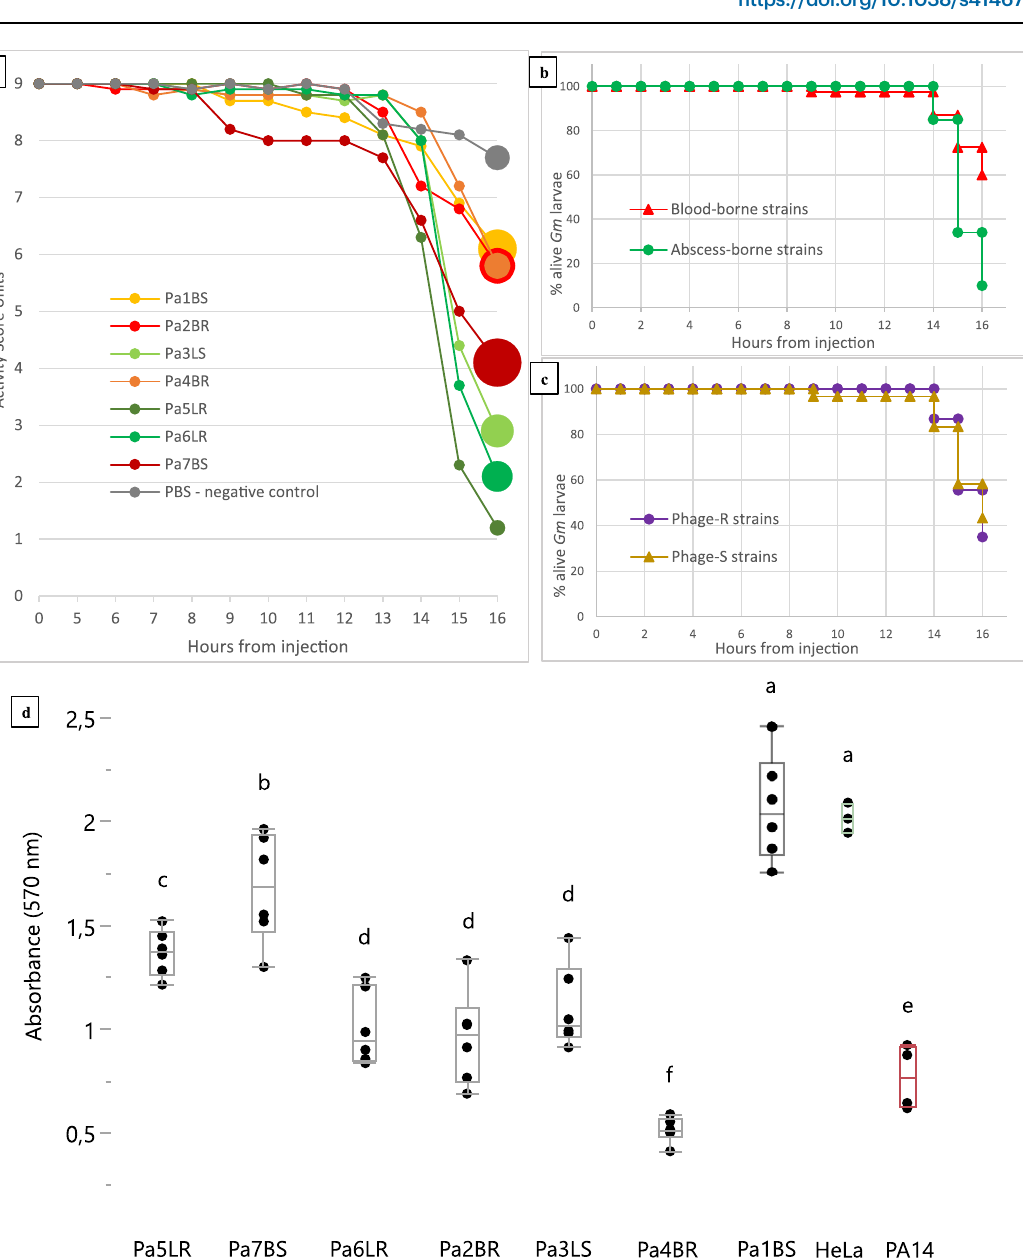
Fig.3|Virulenceassays.a Chronologicalevolutionofthemeanactivityscoreof Gm larvaeinjectedwithphosphate-bufferedsaline(control)oranyoftheseven Pseudomonas aeruginosa isolates retrieved just before (Pa1 BS ) and during (Pa2 BR − Pa7 BS ) phage therapy. Full lines represent the mean activity scores of Gm larvae injected with any of four PNM-resistant P. aeruginosa isolates (Pa2 BR and Pa4 BR − Pa6 LR ) or phosphate-buffered saline (PBS). Dashed lines were used for the three PNM-susceptible isolates (Pa1 BS , Pa3 LS , and Pa7 BS ). Note that fi